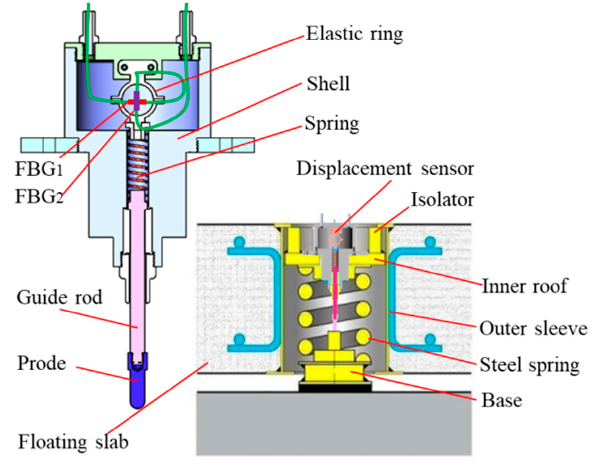
Figure 1. FBG displacement sensor and installation.